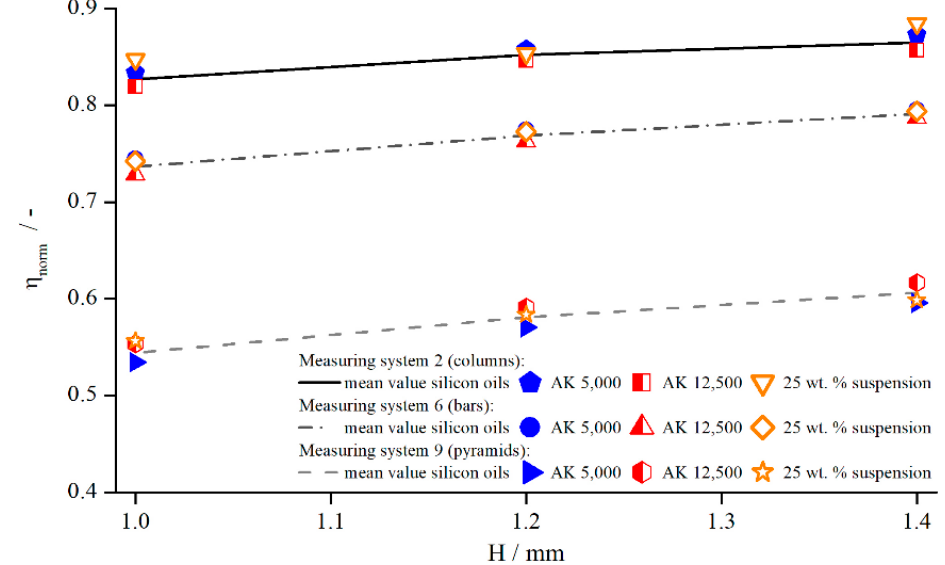
Figure 19. Normalised viscosities of silicon oils and 25 wt. % suspension dependent on the measuring gap, measured with columns (system 2), bars (system 6), and pyramids (system 9) at 𝛾(cid:4662) = 5.05 s (cid:2879)(cid:2869) .